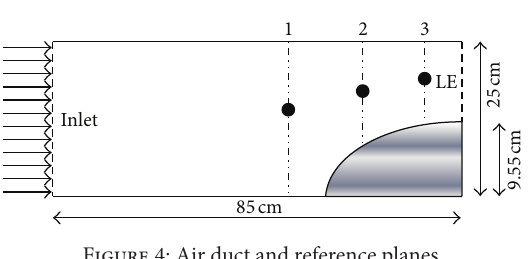
Figure 1: Velocity profiles.